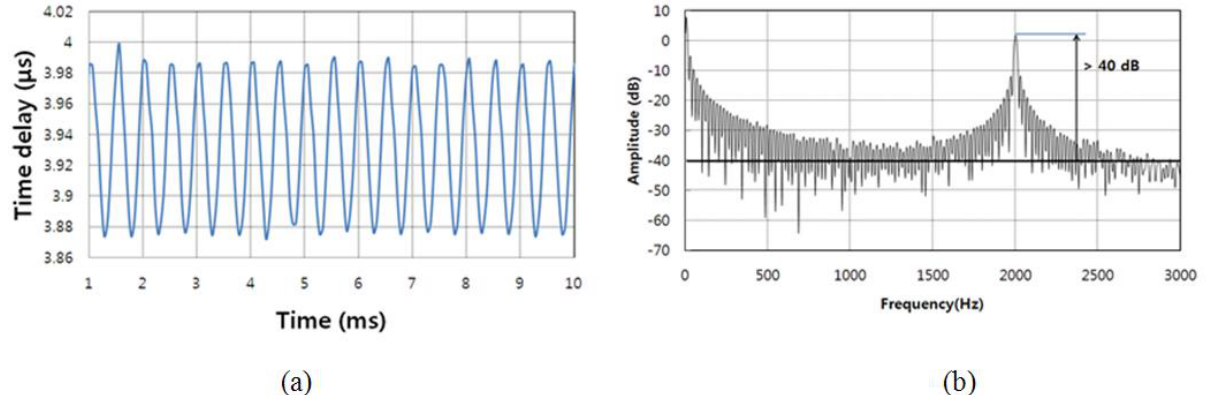
Figure 7. ( a ) Periodic sensor output signal at 2 kHz; and ( b ) power spectral density of the FFT spectrum of